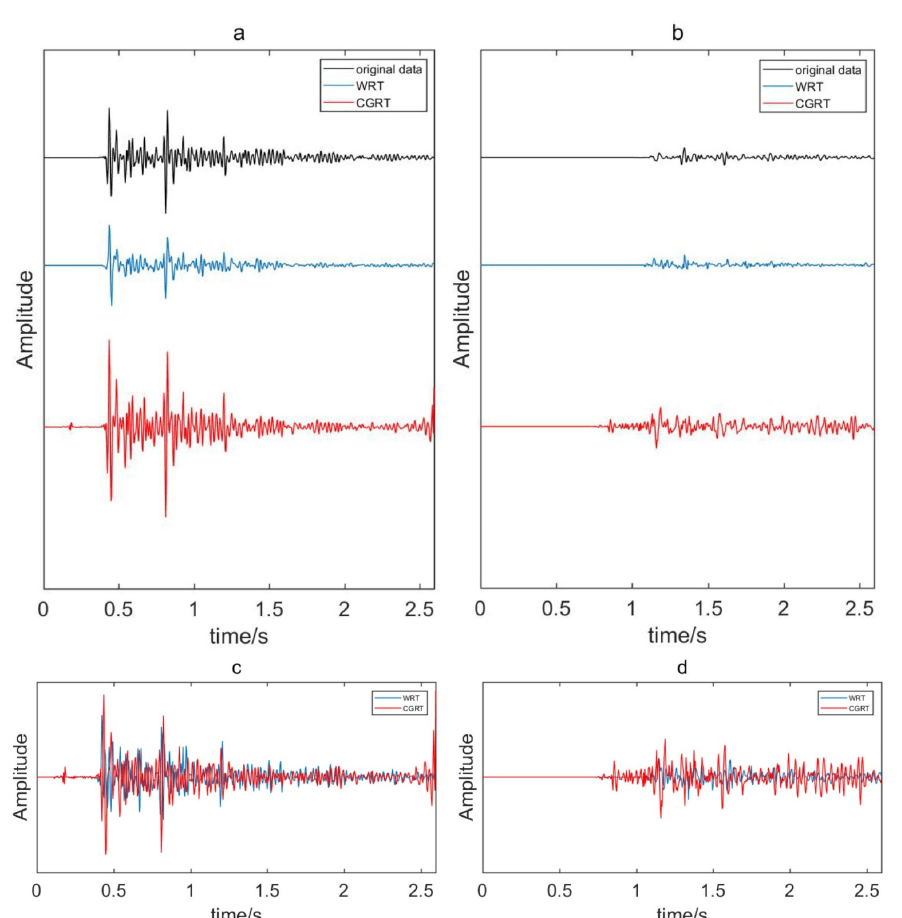
Figure 12. ( a ) Waveform at trace 10; ( b ) waveform at reconstruction trace 64; ( c ) waveform residual at trace 10; ( d ) wave- form residual at reconstruction trace 64.